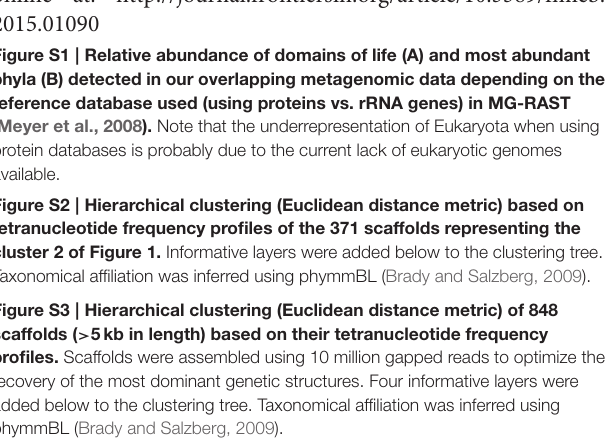
Figure S1 | Relative abundance of domains of life (A) and most abundant phyla (B) detected in our overlapping metagenomic data depending on the reference database used (using proteins vs. rRNA genes) in MG-RAST (Meyer et al., 2008). Note that the underrepresentation of Eukaryota when using protein databases is probably due to the current lack of eukaryotic genomes available. Figure S2 | Hierarchical clustering (Euclidean distance metric) based on tetranucleotide frequency profiles of the 371 scaffolds representing the cluster 2 of Figure 1. Informative layers were added below to the clustering tree. Taxonomical affiliation was inferred using phymmBL (Brady and Salzberg, 2009). Figure S3 | Hierarchical clustering (Euclidean distance metric) of 848 scaffolds ( > 5kb in length) based on their tetranucleotide frequency profiles. Scaffolds were assembled using 10 million gapped reads to optimize the recovery of the most dominant genetic structures. Four informative layers were added below to the clustering tree. Taxonomical affiliation was inferred using phymmBL (Brady and Salzberg,